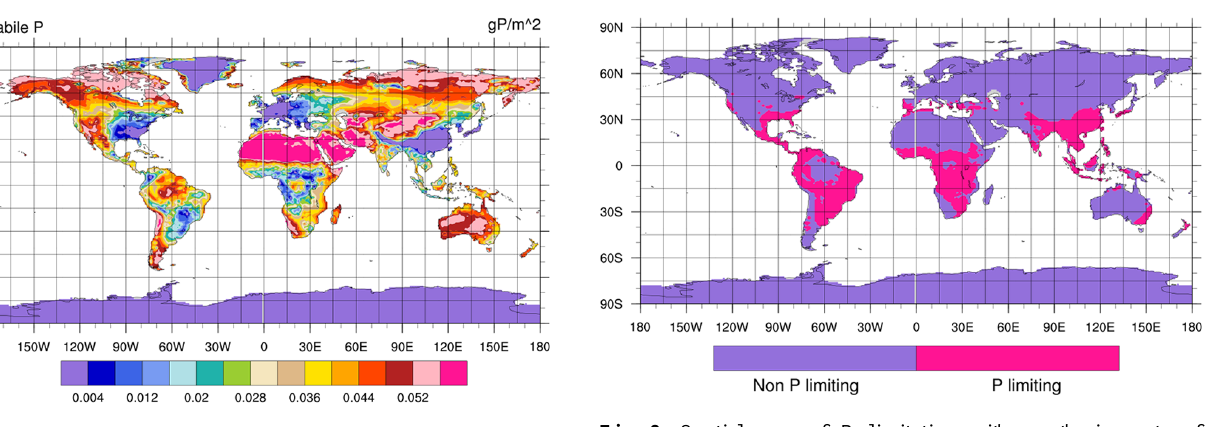
Fig. 8. Spatial map of P limitation with weathering rate of 0.01gPm − 2 yr − 1